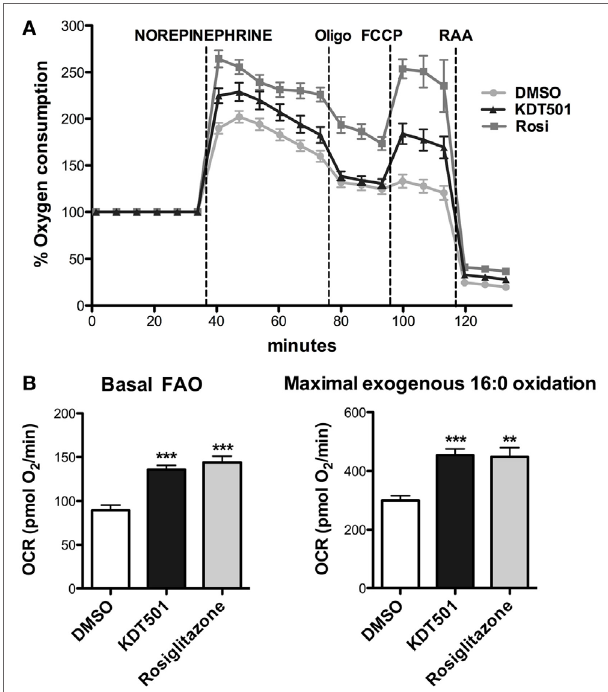
FiGUrE 3 | Adipocytes treated with KDT501 show a magnified response to norepinephrine and increased fatty acid oxidation rate. (a) Mouse primary brown adipocytes were treated for 16 h with DMSO (vehicle), KDT501 (10 µM), or rosiglitazone (2 µM). Oxygen consumption rate was measured on a Seahorse XFe96 as described in the Section “Materials and Methods.” (B) 3T3-L1 adipocytes were treated for 48 h with KDT501 (10 µM) or rosiglitazone (2 µM), and the rate of basal (endogenous) and maximal (exogenous palmitate added) fatty acid oxidation measured in real time using the XFe96. Data represent four biological replicates. Error bars indicate SD. ** P < 0.01; *** P < 0.001 by one-way analysis of